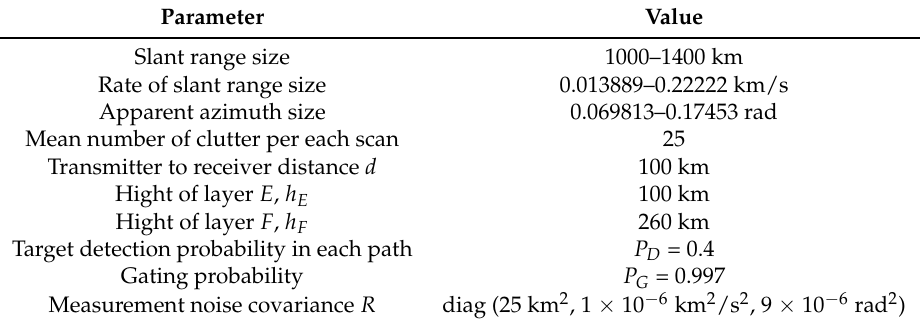
Table 2. Simulation parameters.